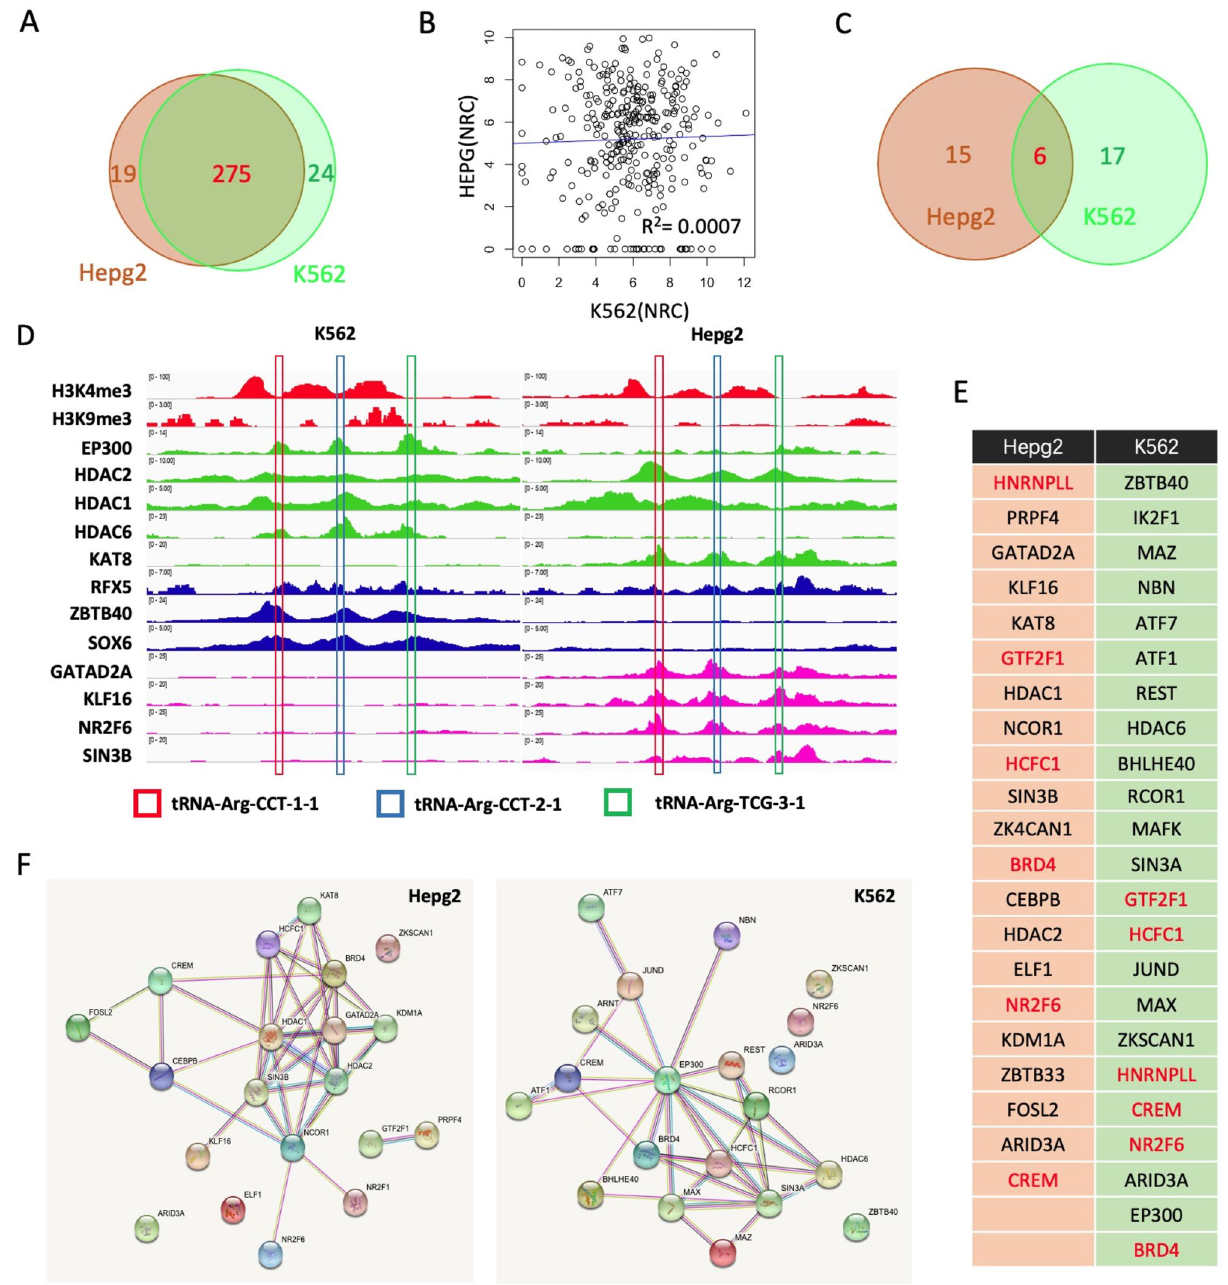
Figure 2. Comparison of tRNA regulation networks of K562 and HepG2 cells. ( A ) Venn diagram showing the overlapping category I tRNAs in two cell lines. ( B ) Venn diagram of the top tRNA-binding DBPs in two cell lines. ( C ) Correlation of the expression level (normalized read counts) of category I tRNAs in two cell lines. Each dot represents a tRNA gene, and R-squared indicates to what extent the variance in K562 cells explains the variance in HepG2 cells. ( D ) A snapshot of aligned ChIP-Seq profiles of two histone methylation markers and 12 DBPs of three tRNA genes in two cell lines. The red, blue, and green rectangles indicate the locations of tRNA-Arg-CCT-1-1, tRNA-Arg-CCT-2-1, and tRNA-Arg-CCG-3-1, respectively, which are very close to each other. ( E ) A table listing the top tRNA gene-binding DBPs in two cell lines; shared DBPs are red. ( F ) The protein–protein interaction/association networks for top DBPs in HepG2 and K562 cells constructed by the STRING server (https ://strin g-db.org/) with default